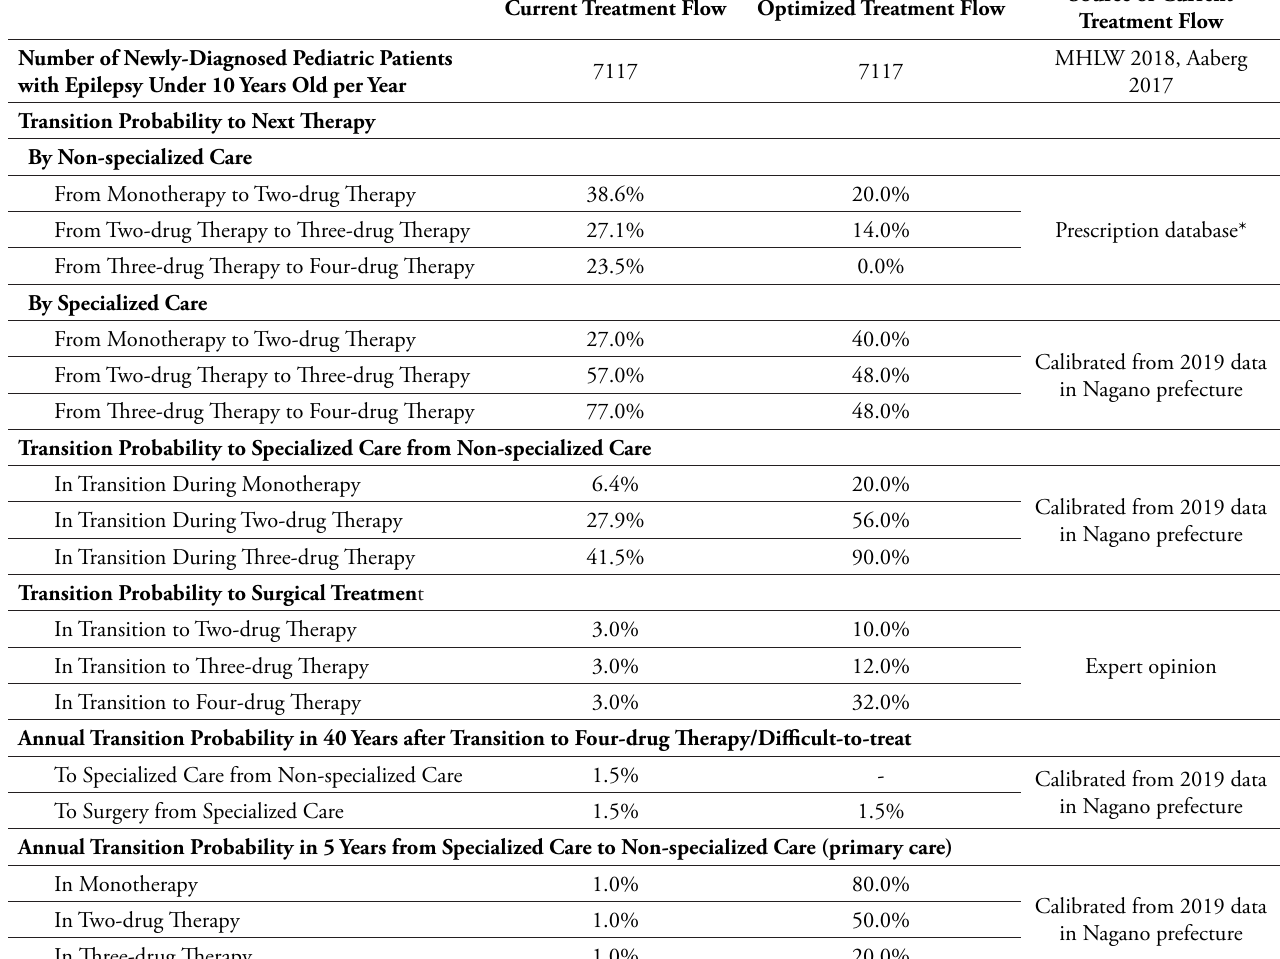
Table 1: Clinical Parameters in